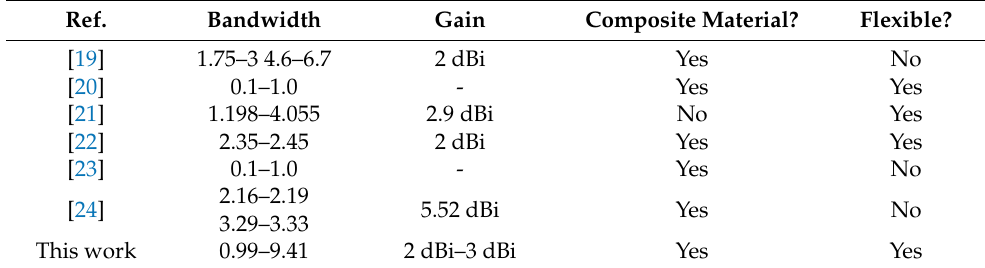
Table 1. A comparison of proposed antennas with recent